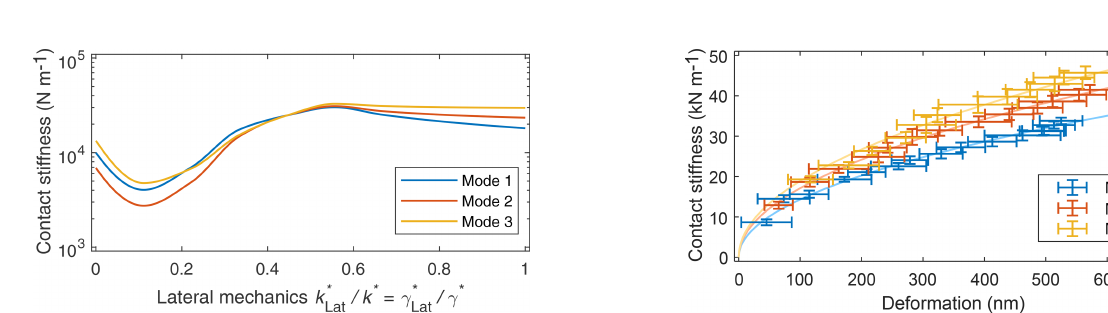
Figure 13. Calculated contact stiffness of the measured lowest three resonance peaks. Varying the assumed length of the cantilever improves the consistency of the model calculations. (a) Lateral forces are neglected in this evaluation. No clear optimum cantilever length is found in /k ∗ = γ ∗ /γ ∗ = 0 . 444. Here, an optimum cantilever length is visible at L = 5 . 555mm. this case. (b) Lateral elements are set to k ∗ Lat Lat